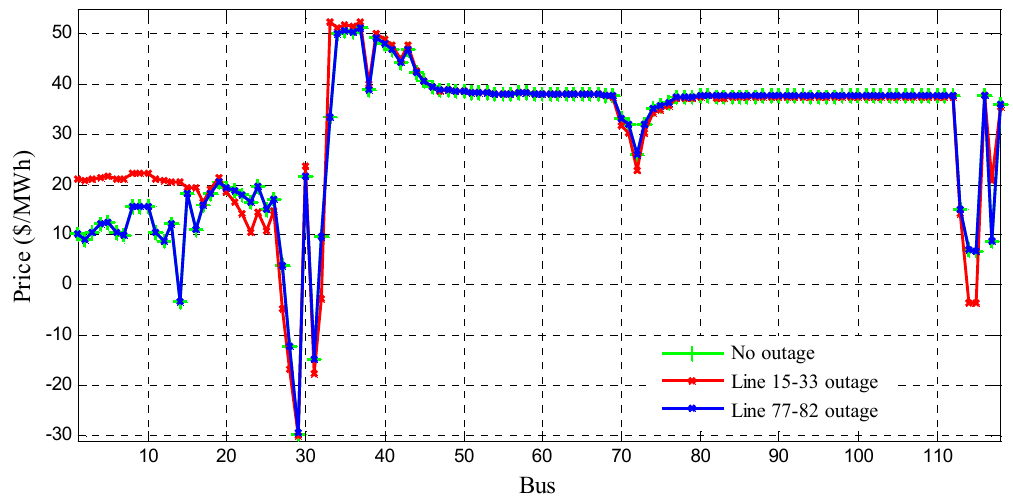
Figure 10. Bus LMPs in IEEE 118-bus system with no outage, line 15–33 and line 77–82 outage.